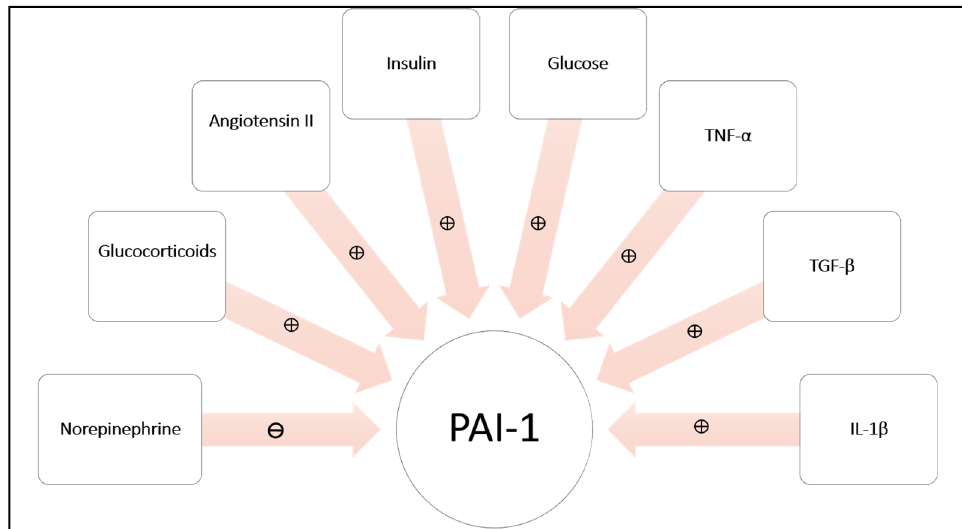
Figure 2. Adipocyte expression and secretion of plasminogen activator inhibitor-1 (PAI-1) is stimulated by glucocorticoids, angiotensin II (Ang II), insulin, glucose and a variety of cytokines, including tumour necrosis factor- α (TNF- α ), transforming growth factor- β (TGF- β ), and interleukin-1 β (IL-1 β ). Catecholamines, such as norepinephrine inhibit production of PAI-1.